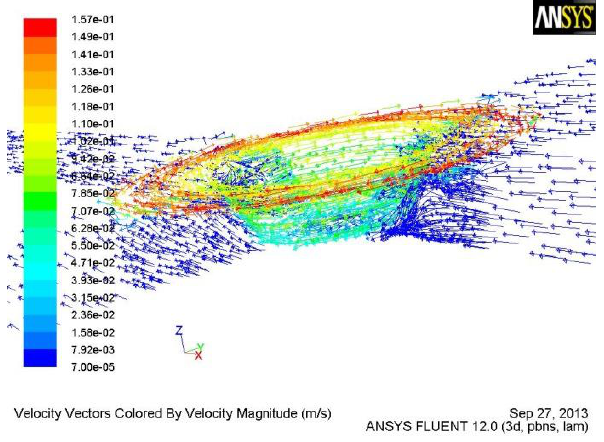
Figure 4. 3D material flow field by the tool with the tapered-flute pin.